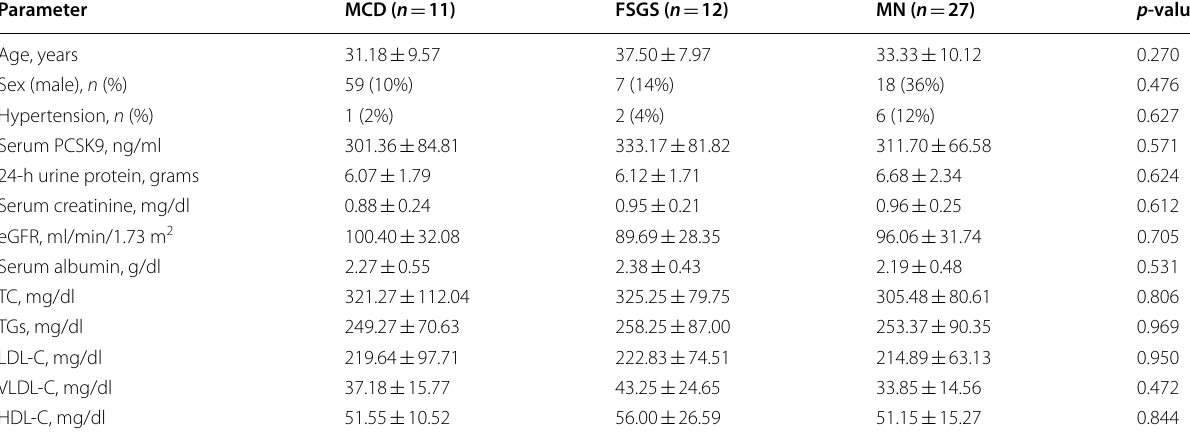
Table 2 Characteristics of the study population according to PNS types Parameter